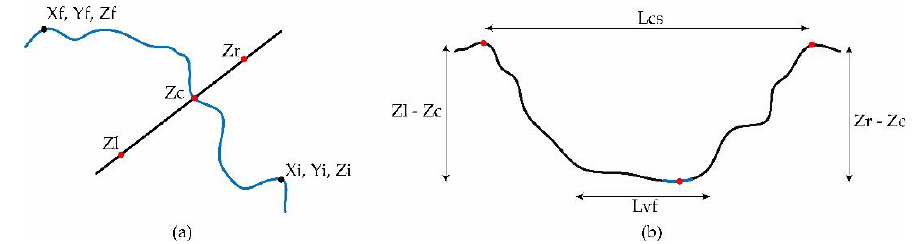
Figure 3. Basic descriptors for each (a) section and (b) cross section.